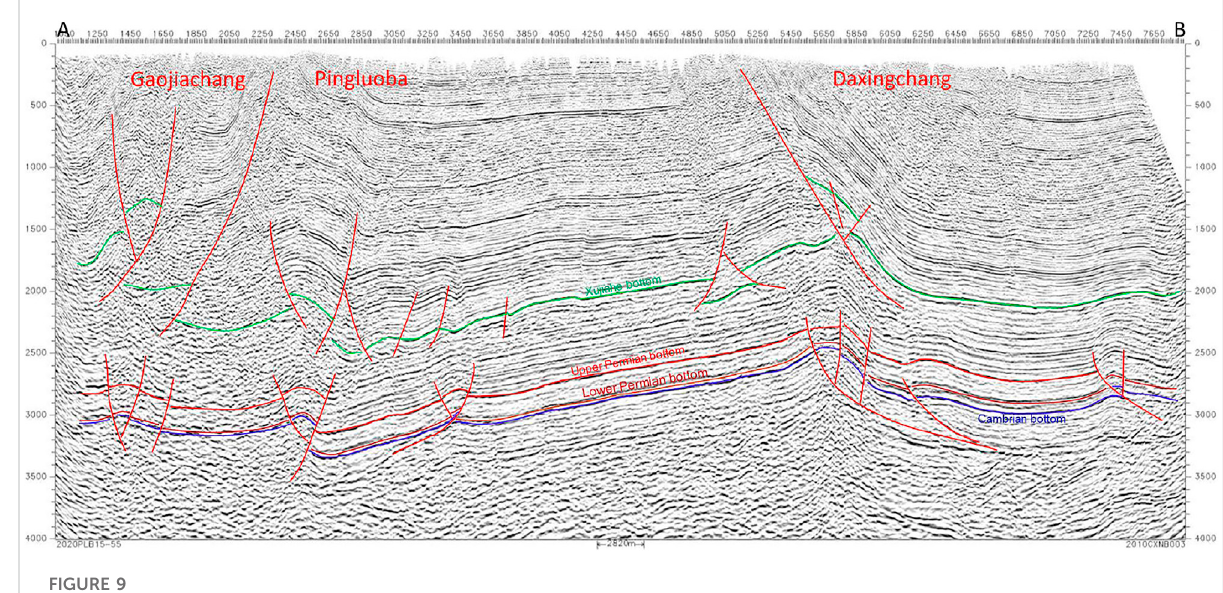
FIGURE 9 Seismic pro fi le showing tectonic style in the southwestern Sichuan